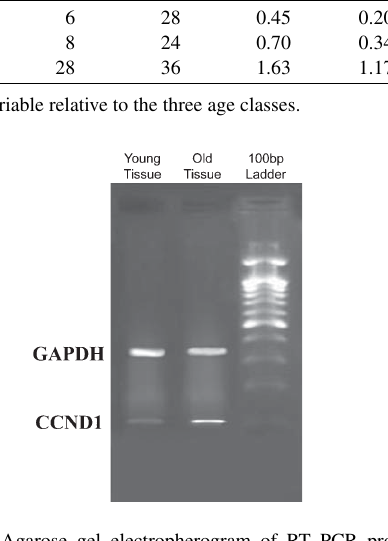
Fig. 1. 2% Agarose gel electropherogram of RT PCR products amplified using human RNA as template, primer pairs of CCND1 and primer pairs of GAPDH as internal control. Lane 1-2 we ran an aliquot containing GAPDH and CCND1 coamplified RT-PCR products of section tumor specimens of young and old patients respectively. Lane 3 we ran a 100bp